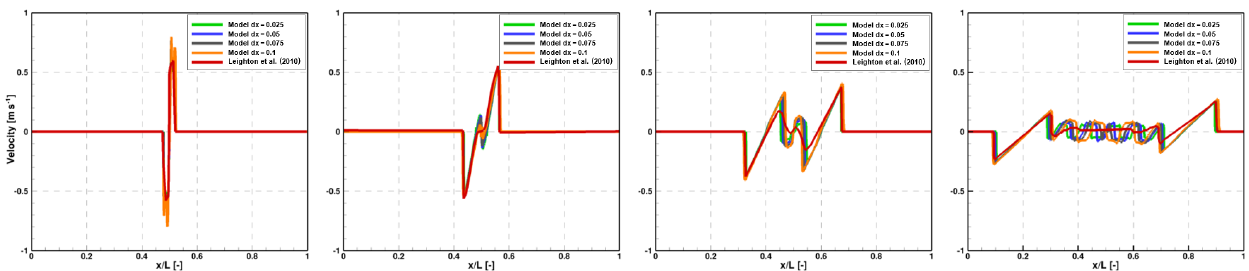
Figure B6. Density driven dam break. Case ρ 2 = 10kgm − 3 : comparison of velocity profiles at ˆ t = 1, 4, 12, and 30s from the beginning of the